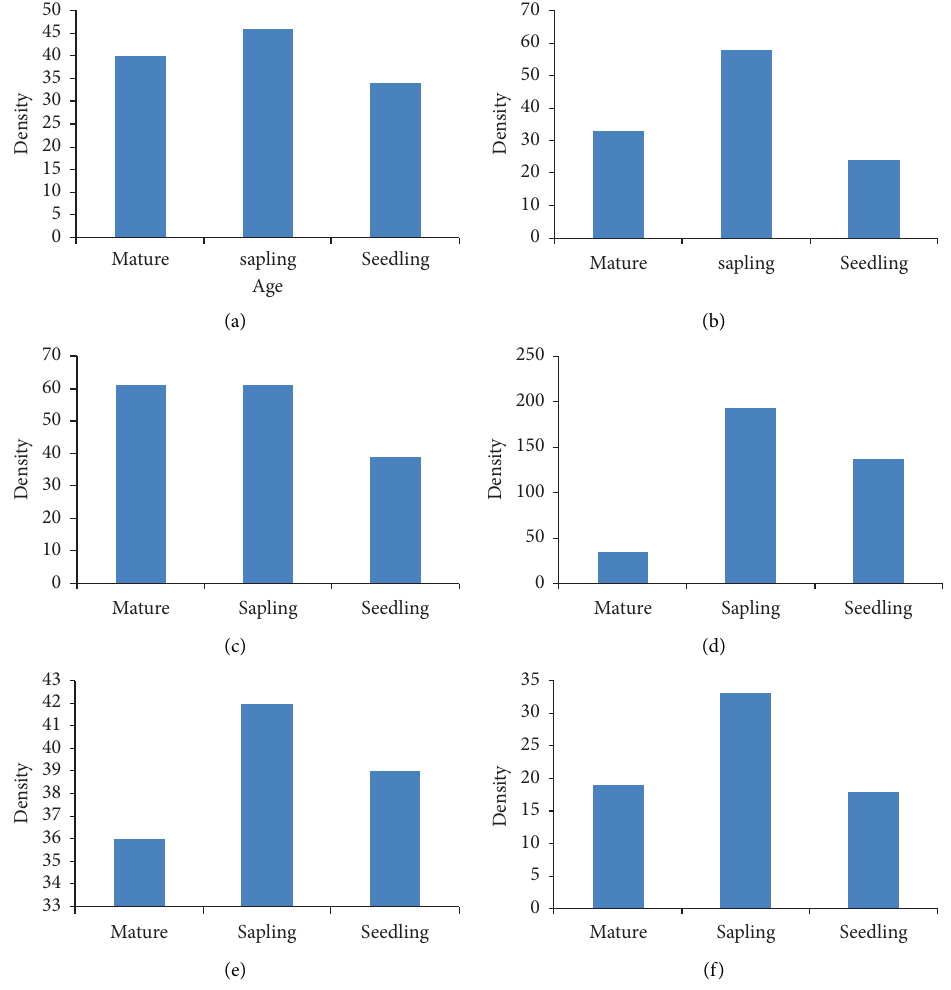
Figure 6: Te regeneration status of some dominant plant species in the study area. (a) Olea europaea . (b) Juniperus procera . (c) Myrica salicifolia . (d) Allophylus abyssinicus . (e) Carissa spinarum . (f) Acacia abyssinica .